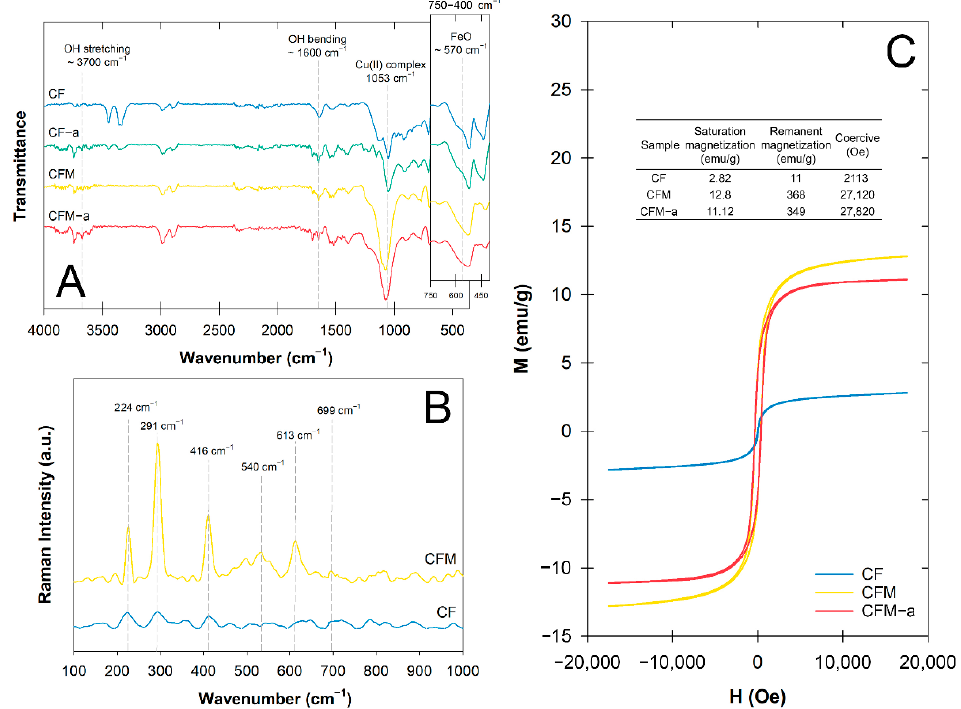
Figure 3. CuFe 2 O 4 /CuO/Fe 2 O 3 ternary nanocomposites: ( A ) FTIR spectra before and after catalytic ozonation, ( B ) Raman spectra, and ( C ) vibrating sample magnetometer hysteresis loops before and after catalytic ozonation.